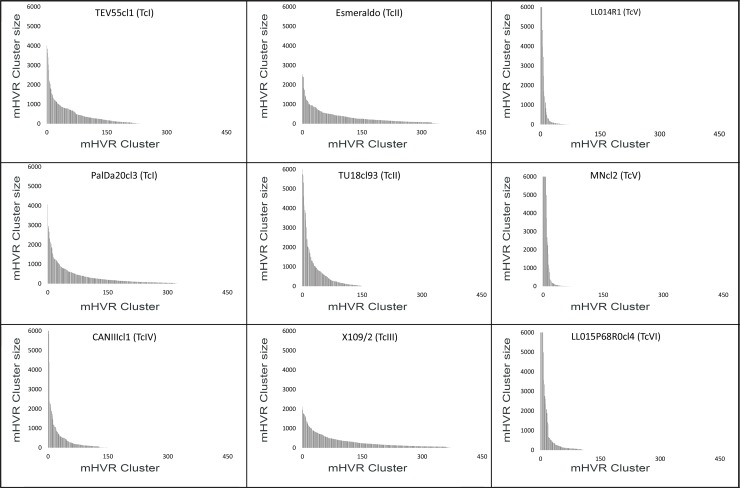
mHVR clusters distributed by size in nine strains.X-axis represent mHVR clusters ordered by decreasing size. The y-axis indicates the mHVR cluster size (i.e. number of reads in the cluster). The cluster size was standardized assuming a total of 120,000 mHVR sequences per parasite (i.e. the value represents the expected cluster size in a kDNA network with 120,000 mHVRs) in order to compare strains with different sequencing depths. Clusters with more than 6,000 sequences were observed for MNcl2, LL014R1, LL015P68R0cl4 and CANIIIcl1 but the bars were cut at this value in order to a clearer comparison among strains.